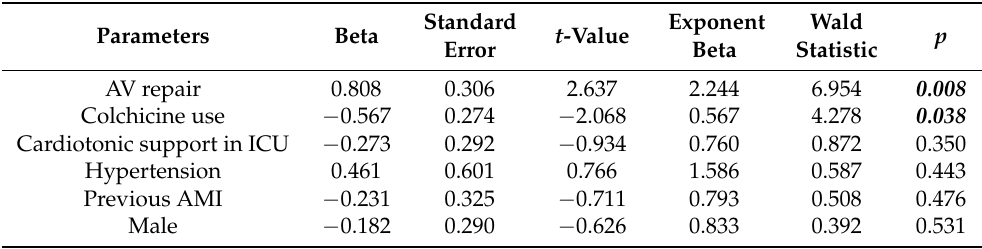
Figure 2. Kaplan-Meier survival and absence of POAF. Table 4. Parameterization of Cox regression model for assessing the risk of developing POAF ( χ 2 = 17.3; p =